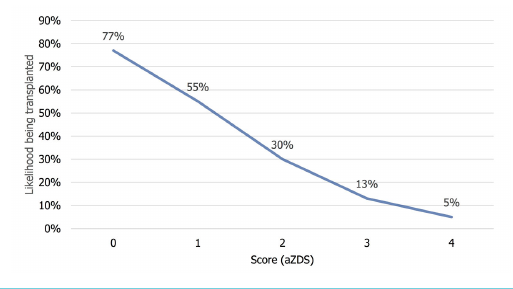
Figure 5: Probability of a donor lung being transplanted in Switzer- land according to adapted Zurich donor score (aZDS), based on a logistic regression model.